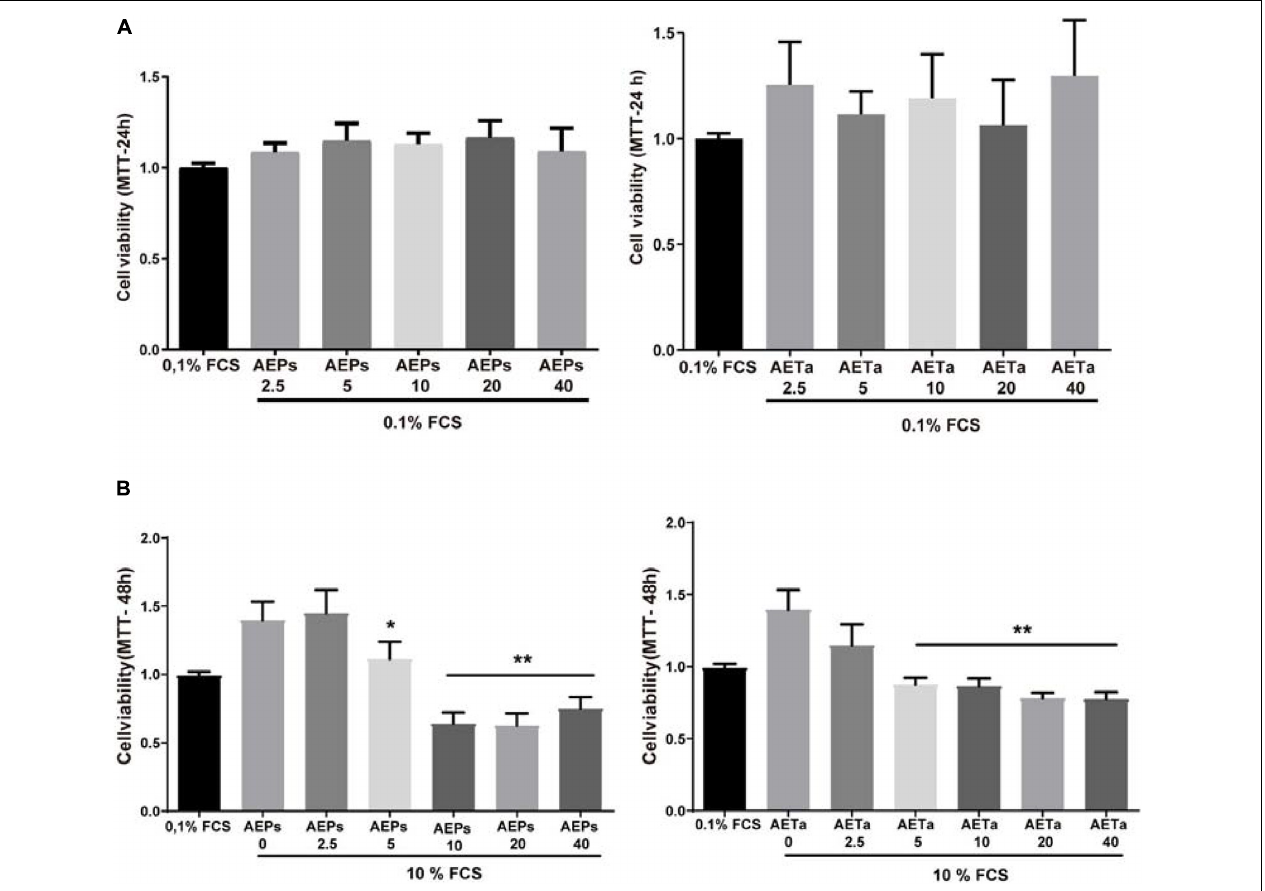
FIGURE 1 | Effect of Prosopis strombulifera and Tessaria absinthioides on VSMC viability and proliferation. (A) VSMCs were incubated with 0.1% FCS containing 0, 2.5, 5, 10, 20, or 40 µ g/ml AEPs or AETa during 24 h. The MTT assay revealed that none of the concentrations of any of the aqueous extracts used in the assay showed a cytotoxic effect. (B) Cells were treated with 0, 2.5, 5, 10, 20, or 40 µ g/ml of AEPs or AETa and stimulated with 10% FCS. MTT assay revealed a dose-dependent reduction in cell proliferation after exposure to 5, 10, 20, or 40 µ g/ml of AEPs or AETa. Data are shown as the mean ± SEM of three